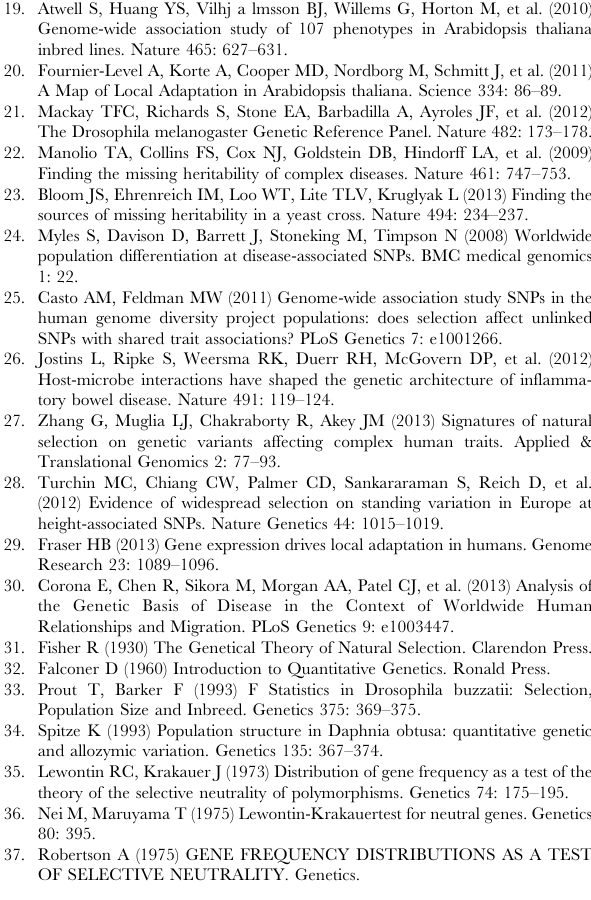
Table S13 Conditional analysis at the regional level for the UC dataset. (PDF) Table S14 Conditional analysis at the individual population level for the UC dataset. (PDF) Table S15 Corresponding b statistics for all analyses presented in Table 2. (PDF) Table S16 Corresponding r statistics for all analyses presented in Table 2.